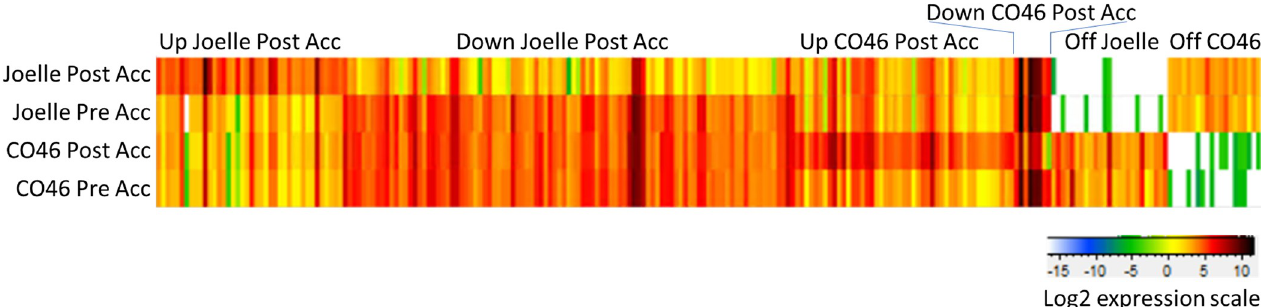
Fig 6. Coordinately regulated gene clusters. Heat map showing clusters of genes uniquely expressed in the various treatments. Treatments are labeled on the left for each row and Clusters are labeled above. The scale for gene expression is depicted as Log2 values of the mean expression from all three replicates of a given treatment is shown in the lower right.